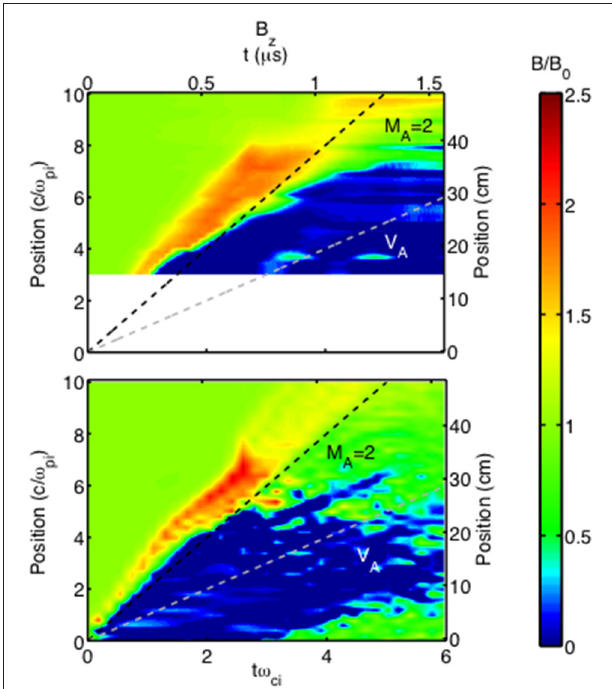
FIGURE 11 | Comparison between experimental data from the UCLA laser experiment (top) and a 2-D hybrid simulation (bottom) . The plots show the magnetic field magnitude, B/B o , as a function of time and space. The formation and evolution of the magnetic cavity (blue region) and the development of a collisionless shock at the edge of the cavity (red) are clearly visible in each plot and show good agreement between simulation and experiment. The plot is from Figure 5 of Clark et al. (2014) and is reproduced with permission from The American Physical Society.